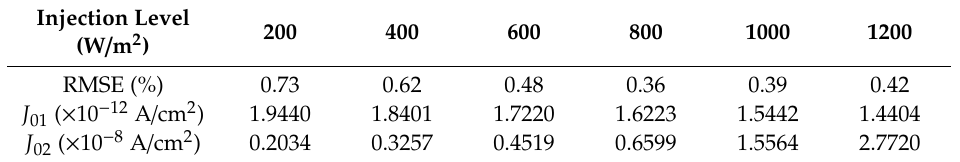
Table 2. The J 01 , J 02 , and root mean square error (RMSE) of current density for an Al-BSF solar cell.